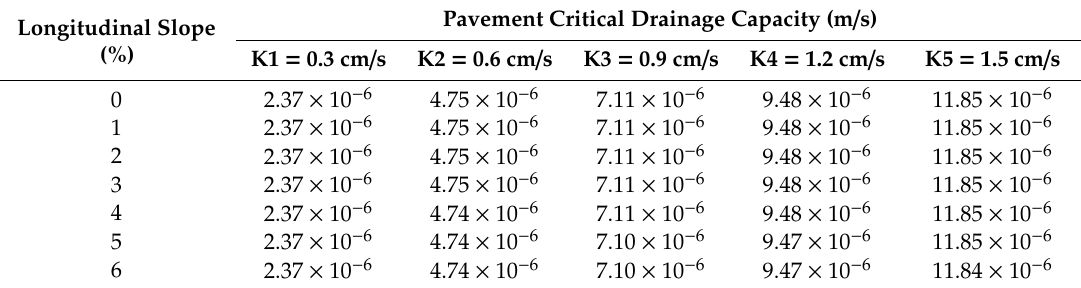
Table 10. Calculation result of the critical drainage capacity of the pavement with di ff erent transverse slope of 4% for the second boundary